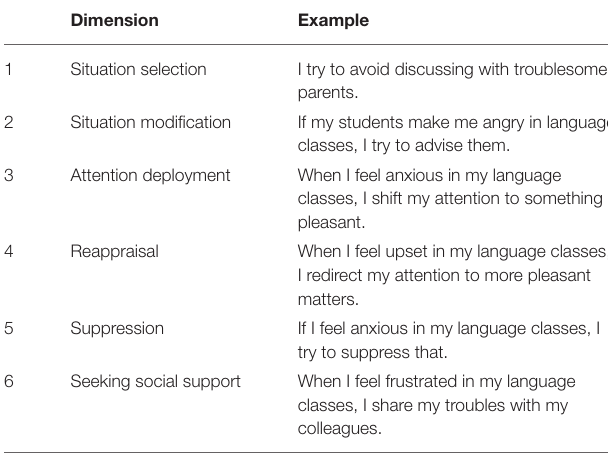
TABLE 1 | Emotion regulation dimensions in the proposed model with examples. Dimension